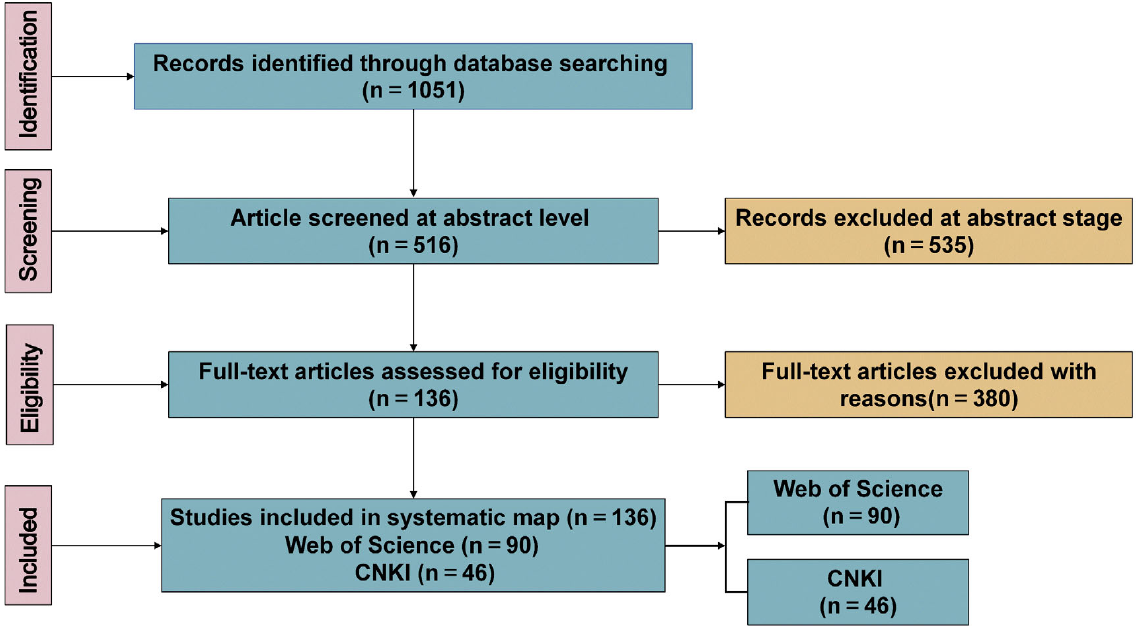
Figure 1. The study’s systematic mapping process illustrates articles from the initial search to screening for synthesis (identification, screening, eligibility, and inclusion). Papers were found through a database search at the identification stage. Then, the articles captured were screened based on the categories of agroforestry structure, agroforestry ecosystem structure concept, characteristics, design principles, optimization strategies, influencing factors, and agroforestry stability (through titles, keywords, abstracts, and full-text articles) at the screening and eligibility stages. Finally, the articles satisfying the eligibility criteria were included in the study.